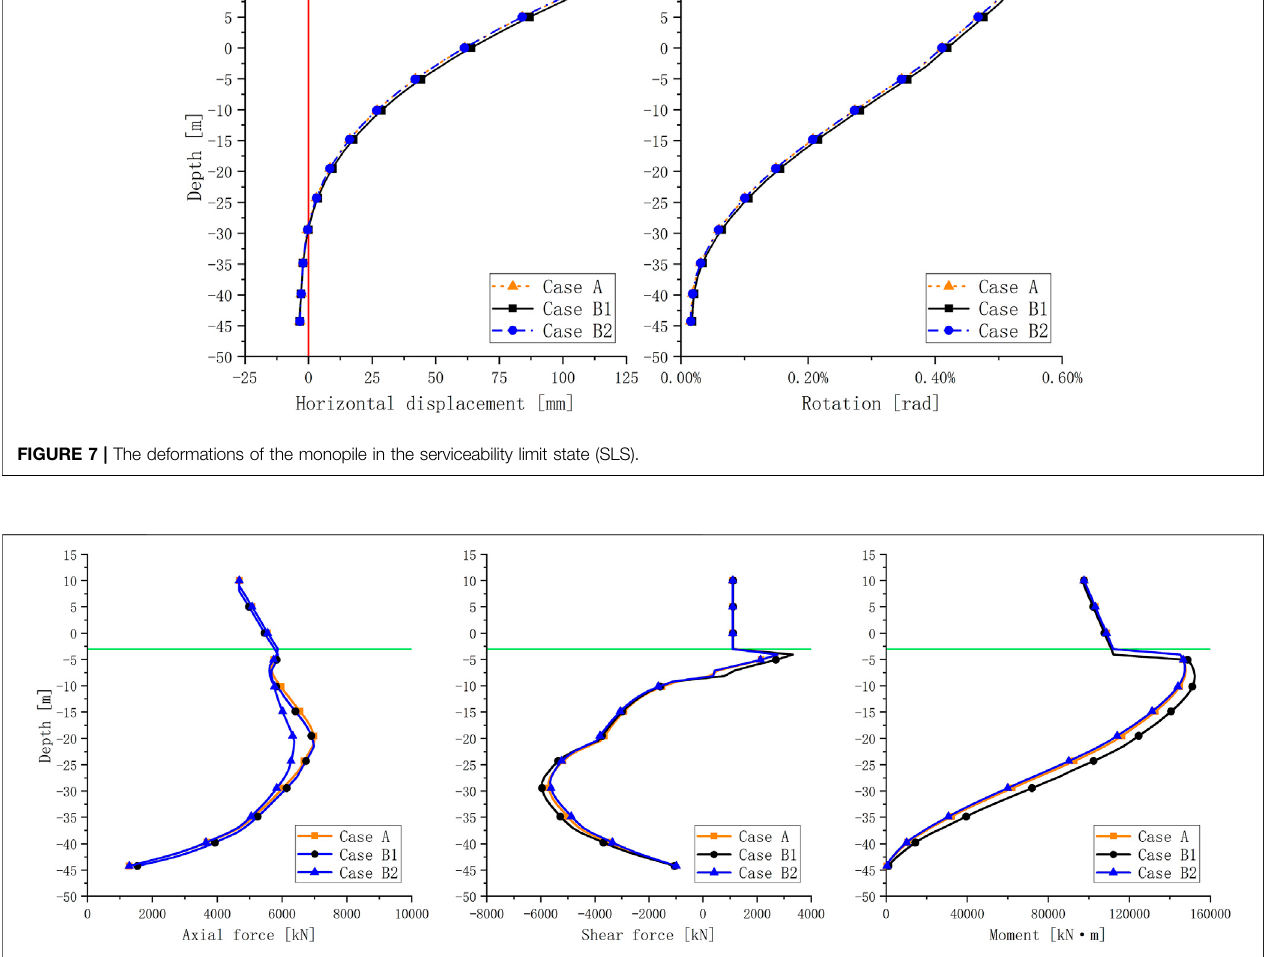
Frontiers in Physics |